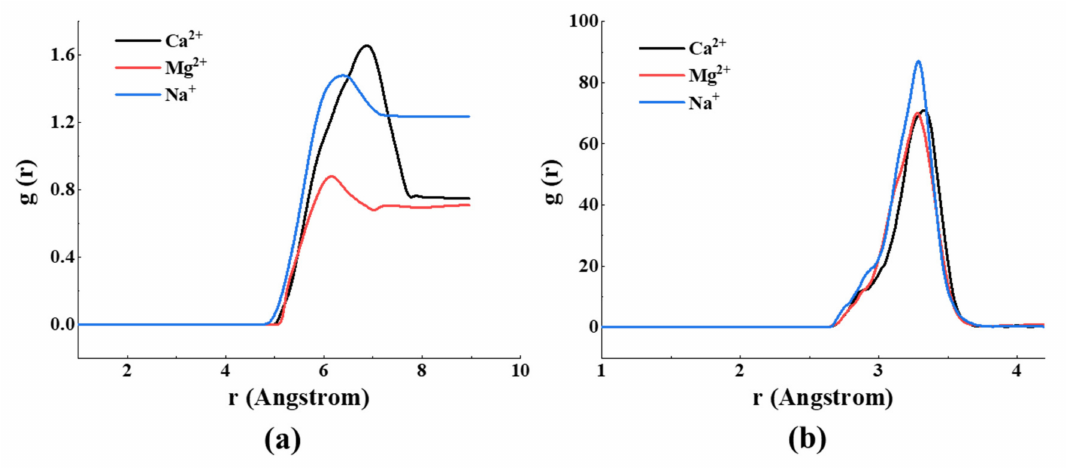
Figure 6. Radial distribution function of cations and zx. ( a ) APG foam system, ( b ) SDS foam system.